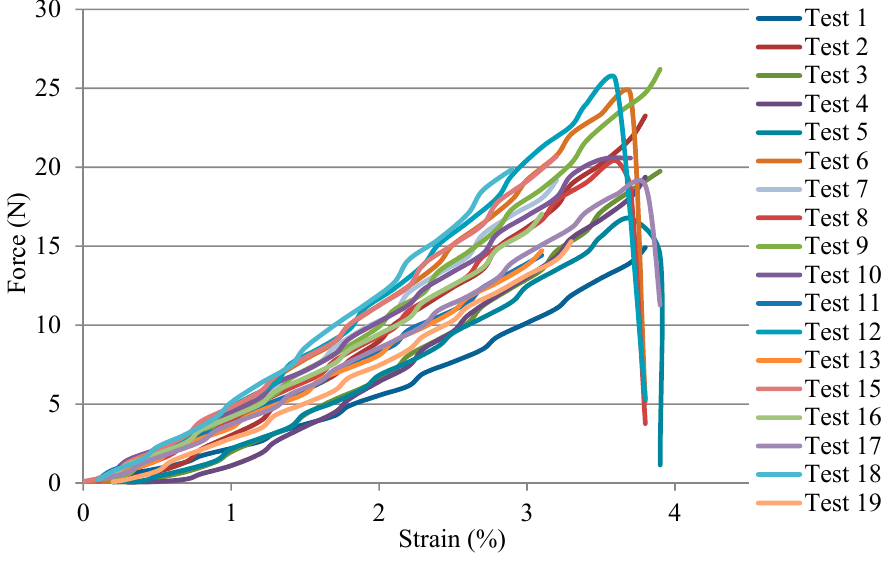
Figure 5. Tensile results of pure flax yarns [28].